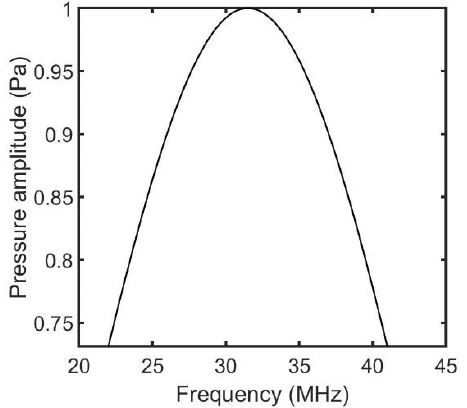
Figure 3. Incident background pressure distribution.